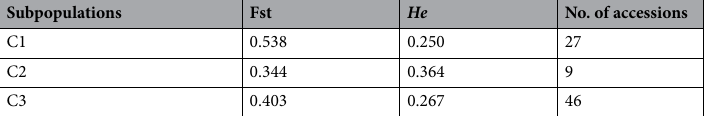
Table 1. The STRU CTU RE analysis of 82 wheat accessions for the fixation index (Fst), expected heterozygosity ( He ) and number of accessions assigned to each subpopulation.